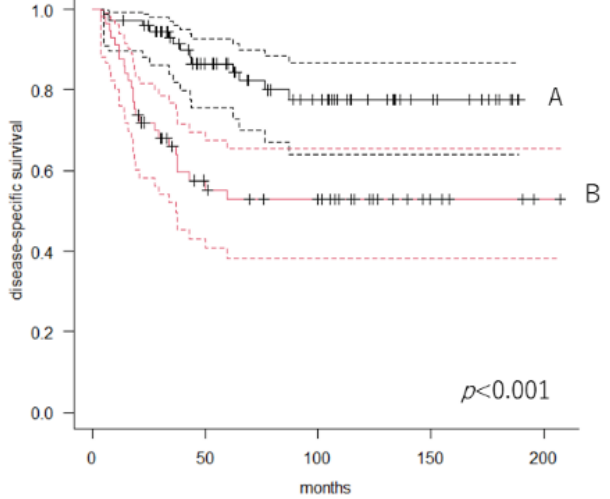
Figure 1. Kaplan–Meier curves showing disease-specific survival. A: Patients with a higher lymphocyte-to-C-reactive protein ratio. B: Patients with a lower lymphocyte-to-C-reactive protein ratio.